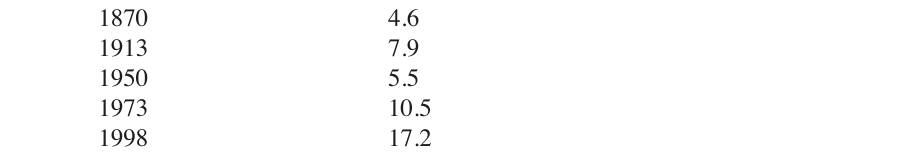
Table 1 Share of world export in world GDP 1870-1998 (Percentage)